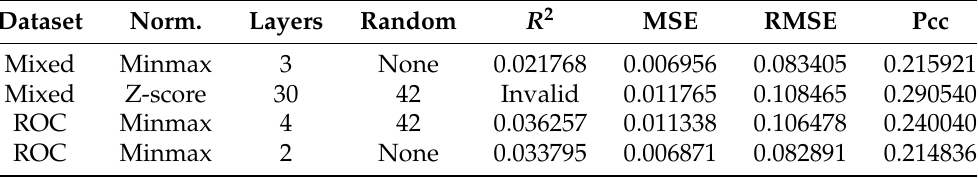
Table 4. Top 2 best metric performers in DNN